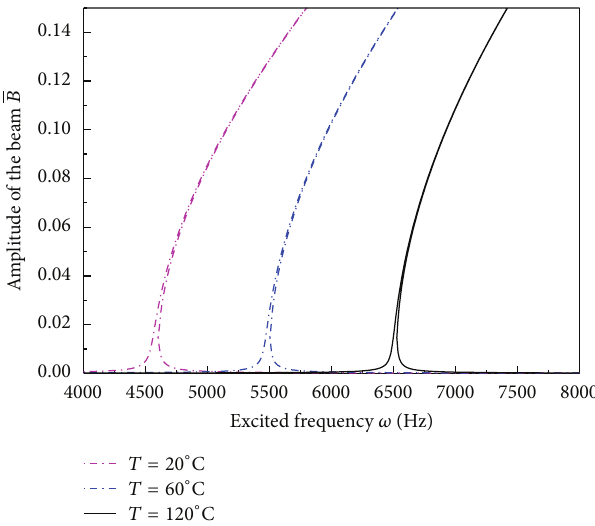
Figure 19: Amplitude 𝐵 versus frequency responses of the com- posite beams in the phase transformation state from martensite to austenite under the excitations for different 𝑇 ( 𝜀 0 = 0.036 , 𝑉 𝑠 = = 10 N, and 𝐿/ℎ = 10 0.005 , 𝑞 0